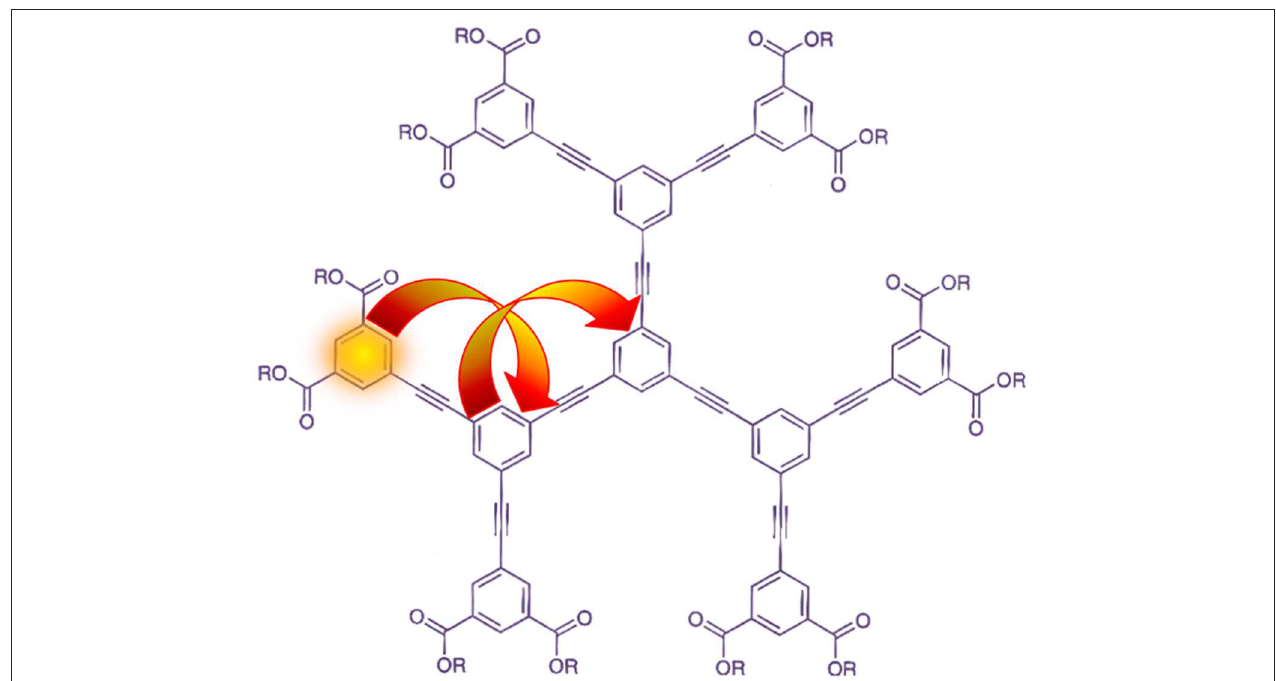
FIGURE 4 | Two-step RET in a second-generation phenylacetylene dendrimer. This schematic depicts initial electronic excitation at a peripheral phenyl group, which acts as a donor of energy to a neighboring inner-ring chromophore; this acceptor then becomes a donor of energy to the phenaline core. Original image appeared in Bradshaw and Andrews [